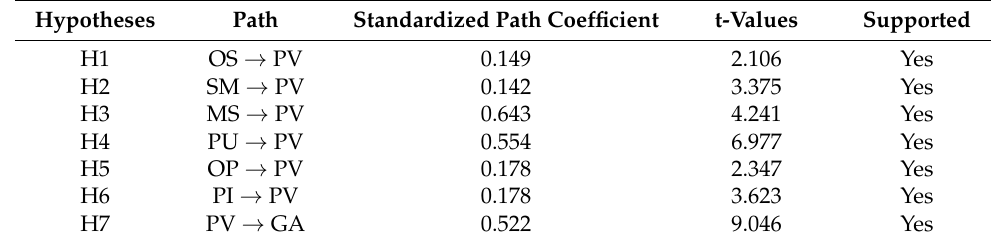
Table 6. Summary of the inner model